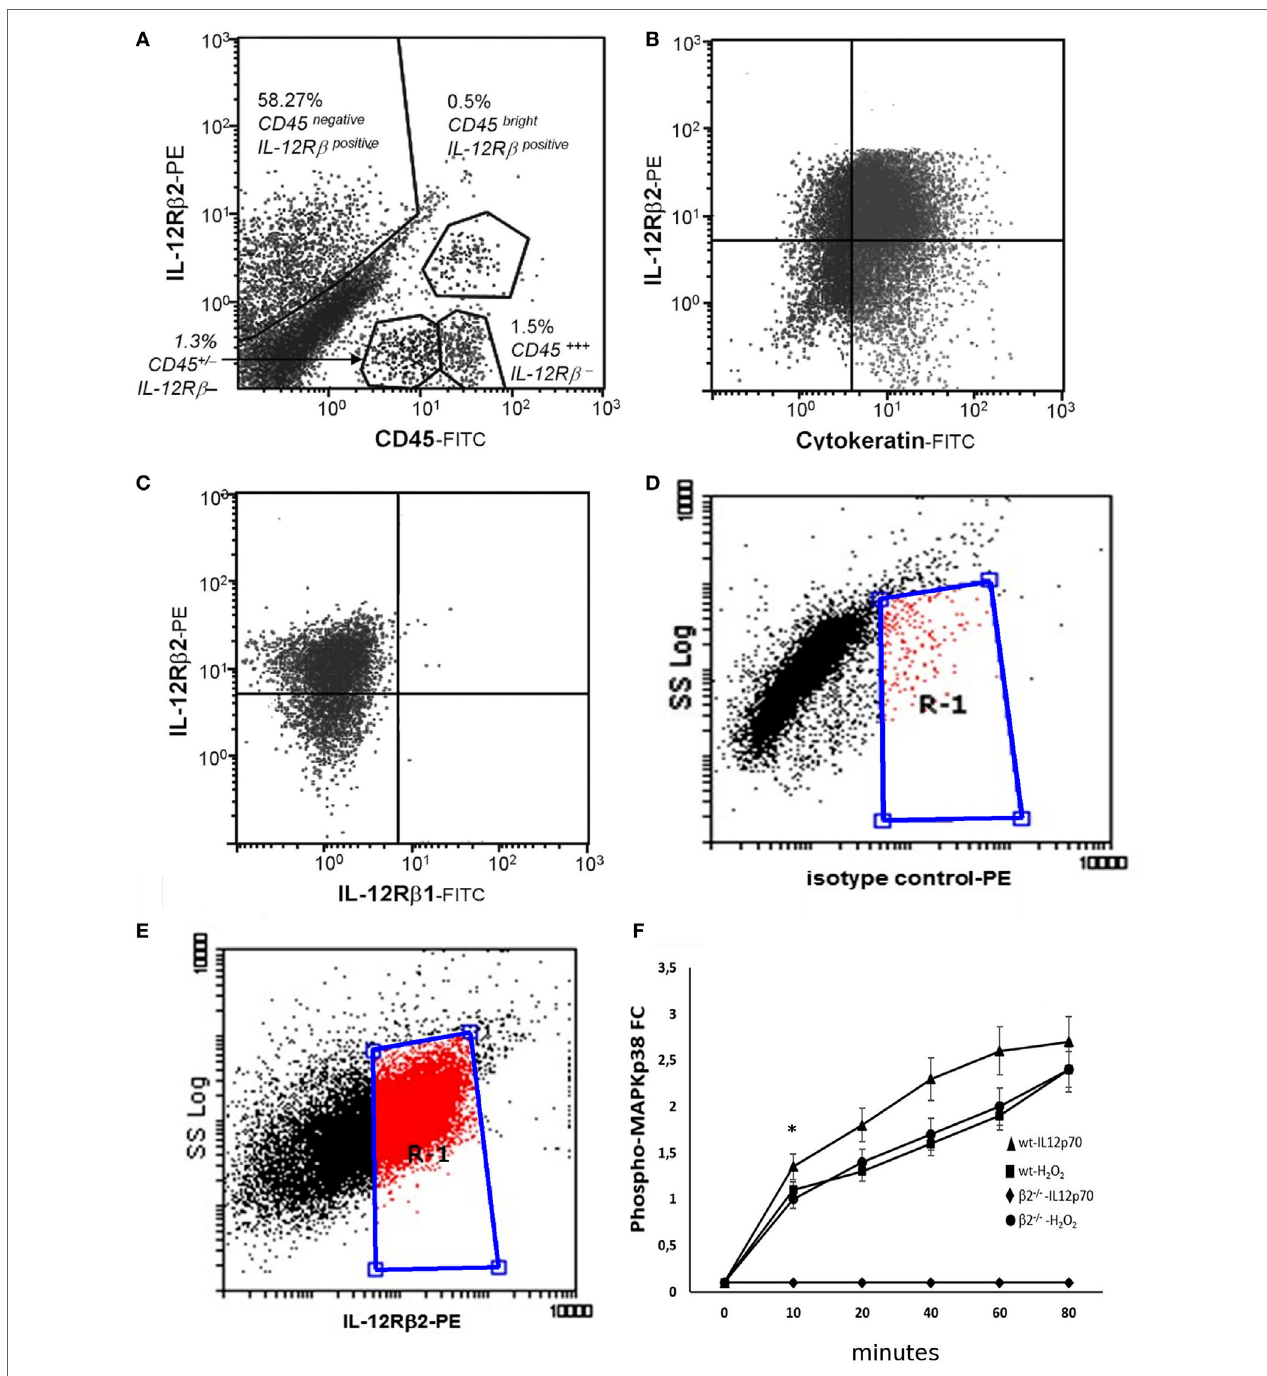
FigUre 1 | Expression and functional integrity of IL-12R β 2 on intestinal epithelial cells (IECs) . Flow cytometry analysis was carried out using epithelial cell suspension to identify intestinal cells expressing IL-12R. IL-12R β 2 chain was detected on approximately 50% of small intestine CD45 − (IECs) cells and in a small proportion ( > 1%) of CD45 + cells (a) . IL-12R β 2 positive cells that did not express CD45 (IL-12R β 2 + CD45 − ) were identified and selected. Their epithelial origin was confirmed through expression of cytokeratin (B) . Furthermore, we showed that the expression of IL-12R β 2 on these cells was not paralleled by the presence of the complementary IL-12R β 1 chain (c) . Also, plots of SSC vs. IL-12R β 2 are shown (D,e) ; Cells were stained with PE-coupled isotype control antibody to facilitate gating and enable detection of non-specific fluorescence (D) . Following staining with PE-coupled anti-IL-12R β 2 antibody, positive cells were identified (e) within the gate R-1 constructed in D above. Finally, ex vivo stimulation of freshly isolated IECs from the mouse small intestine with IL-12p70 led to a rapid increase in intracellular phosphorylation of MAPKp38 only in IEC from wt mice but not IL-12R β 2 − / − mice showing that the upregulation of phospho-MAPK38 is an IL-12R β 2-specific event; stimulation with H 2 O 2 was used as a positive control (F) . Experiments on MAPKp38 were performed in triplicate using freshly isolated IECs (five mice/group). (*) indicates statistical difference. p < 0.05.